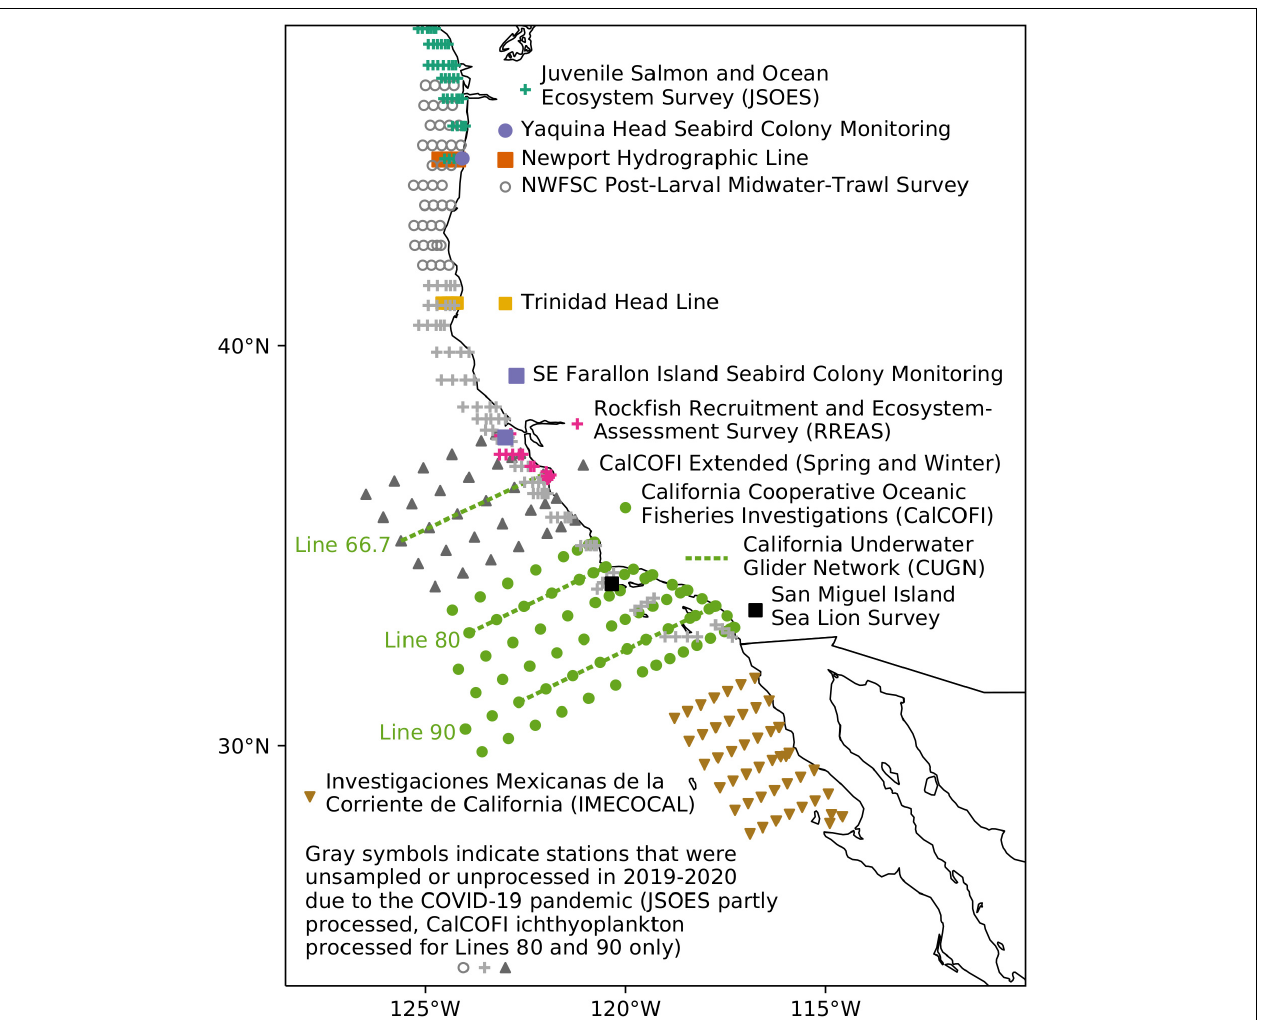
FIGURE 1 | Hydrological and biological surveys used to assess the state of the California Current